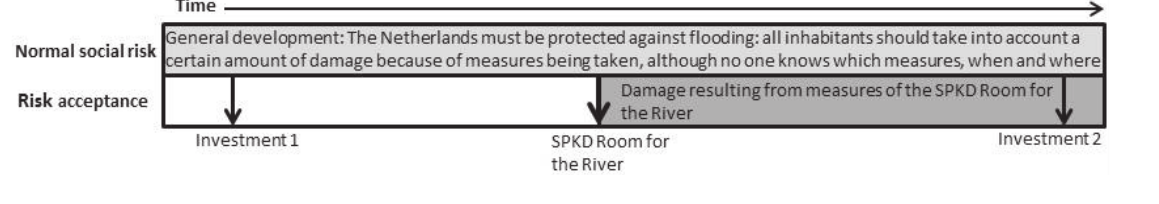
Figure 4 Distinction between normal social risk and risk